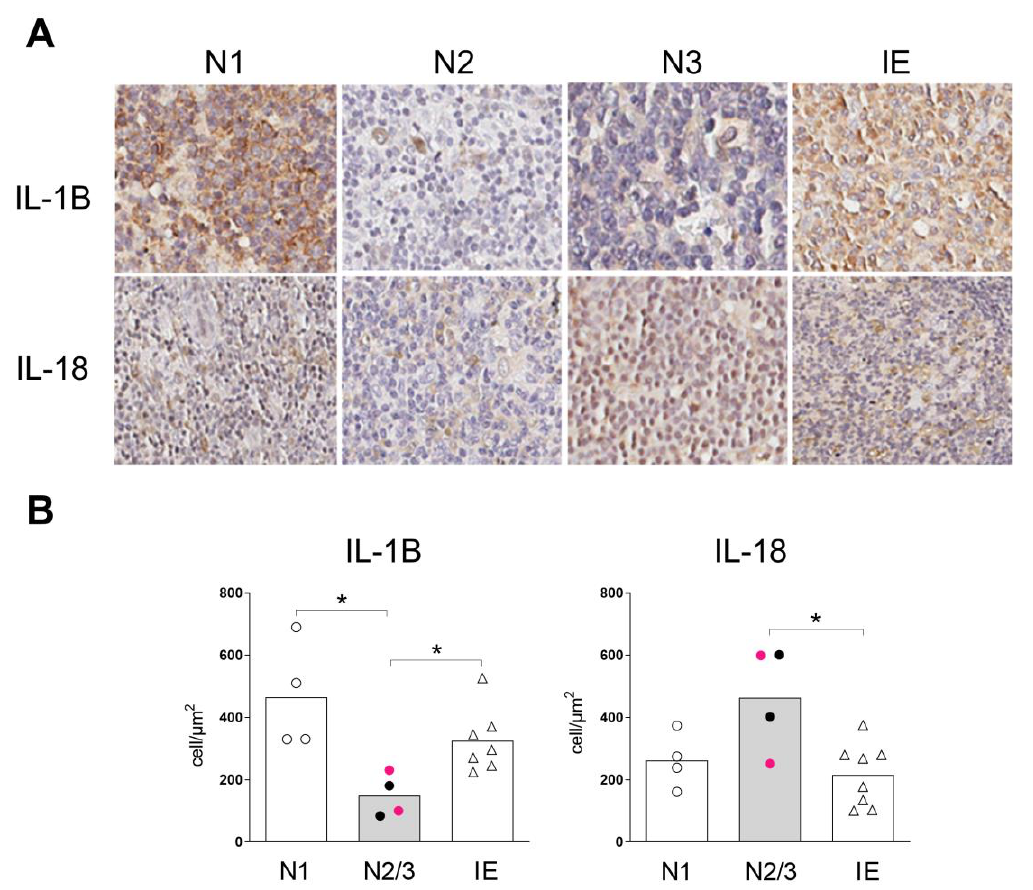
Figure 4. Decreased IL-1B expression and IL-18 upregulation in lymph nodes at an advanced stage of SS. The expressions of IL-1B and IL-18 were assessed in the lymph-node biopsies of SS patients at stages N1 ( n = 4, open circle), N2 ( n = 2, pink circle), and N3 ( n = 2, closed circle), as well as in idiopathic erythroderma patients (IE, n = 8, open triangle), by immunohistochemistry. ( A ) Representative images, original magnification ×20. ( B ) IL-1B expression and IL-18 expression. Data are illustrated by median values. * p ≤ 0.05.